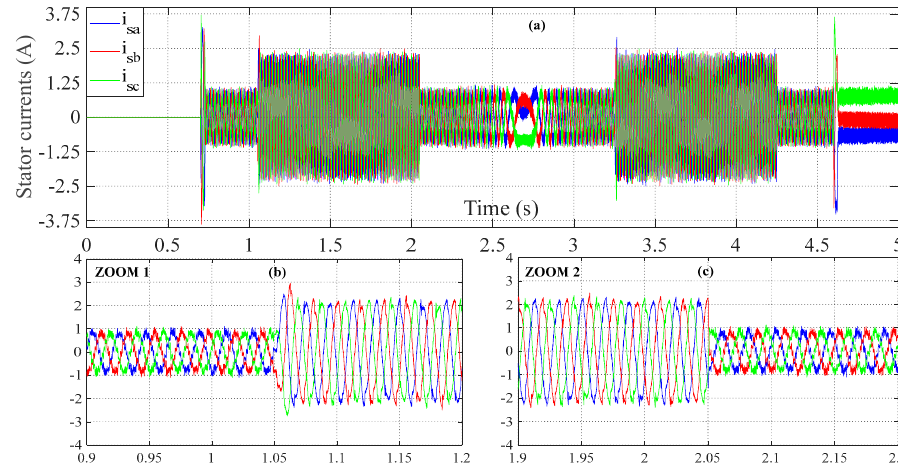
Figure 8. Stator currents ( a – c ) of the DTC.